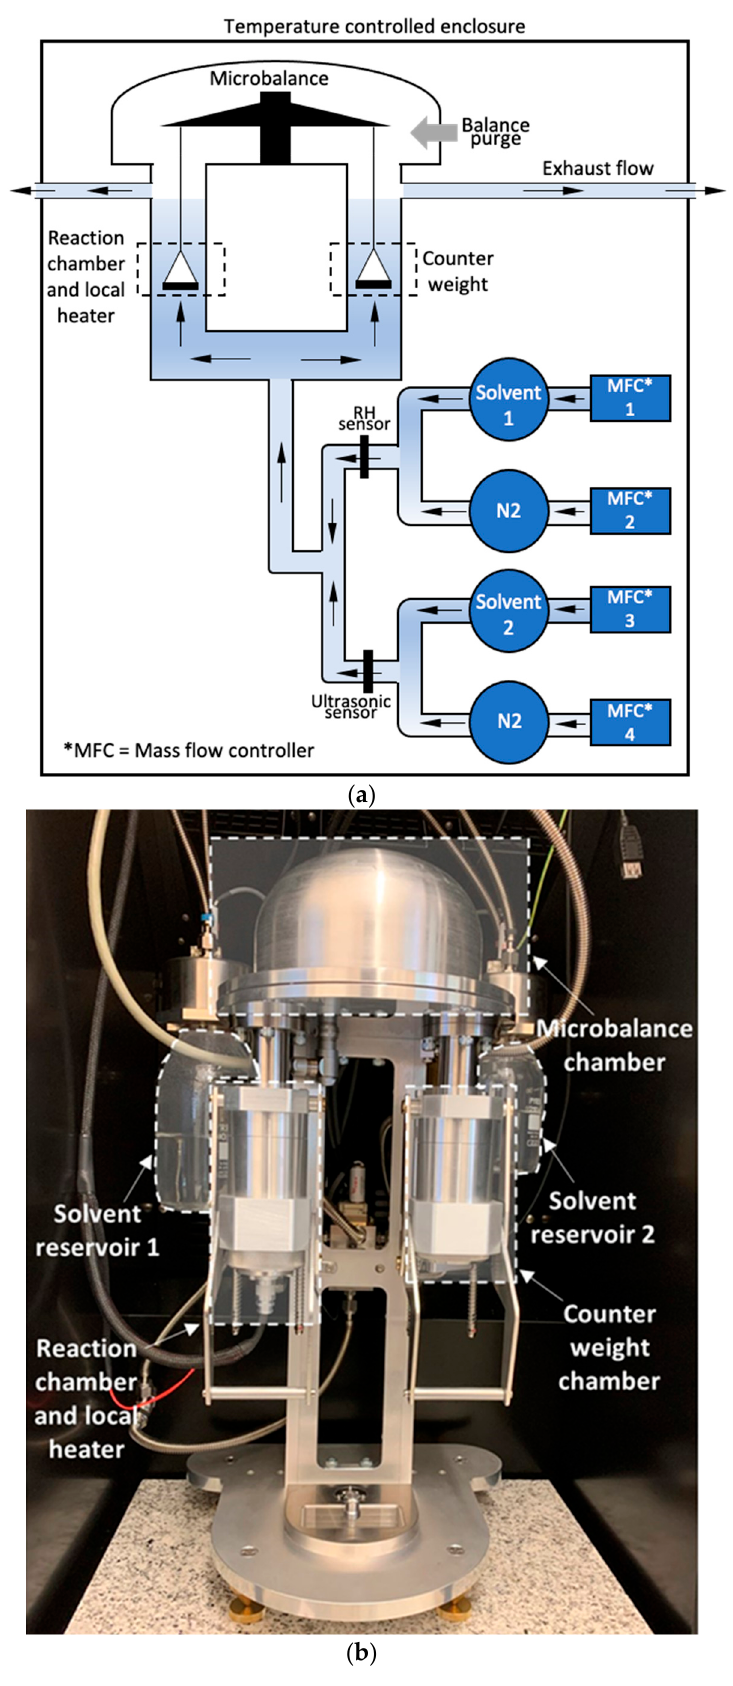
Figure 1. Dynamic vapor sorption analyzer ( a ) schematic diagram and ( b ) pictorial view [32].